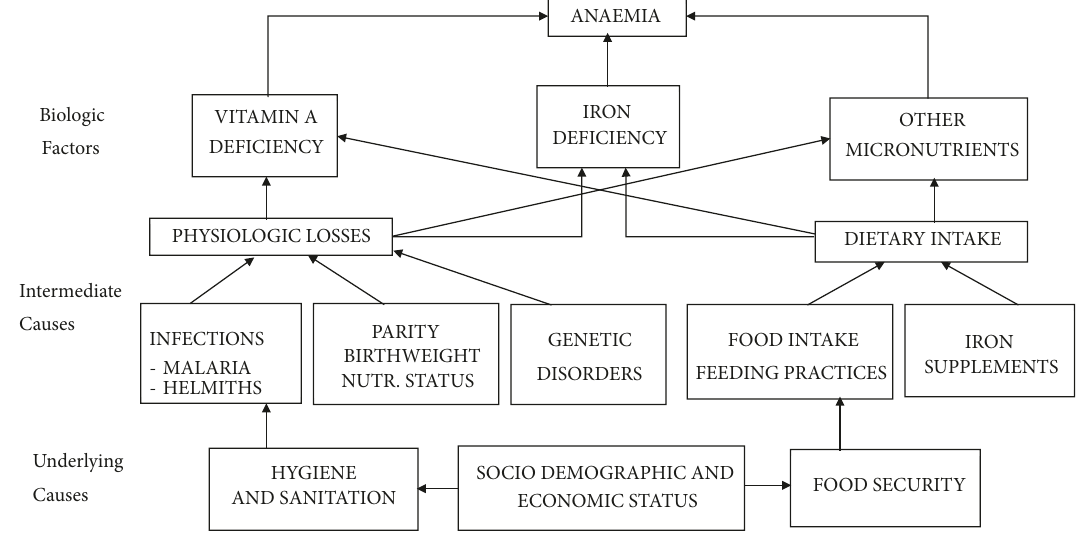
Figure 1: Conceptual framework for causes of childhood anaemia adapted from